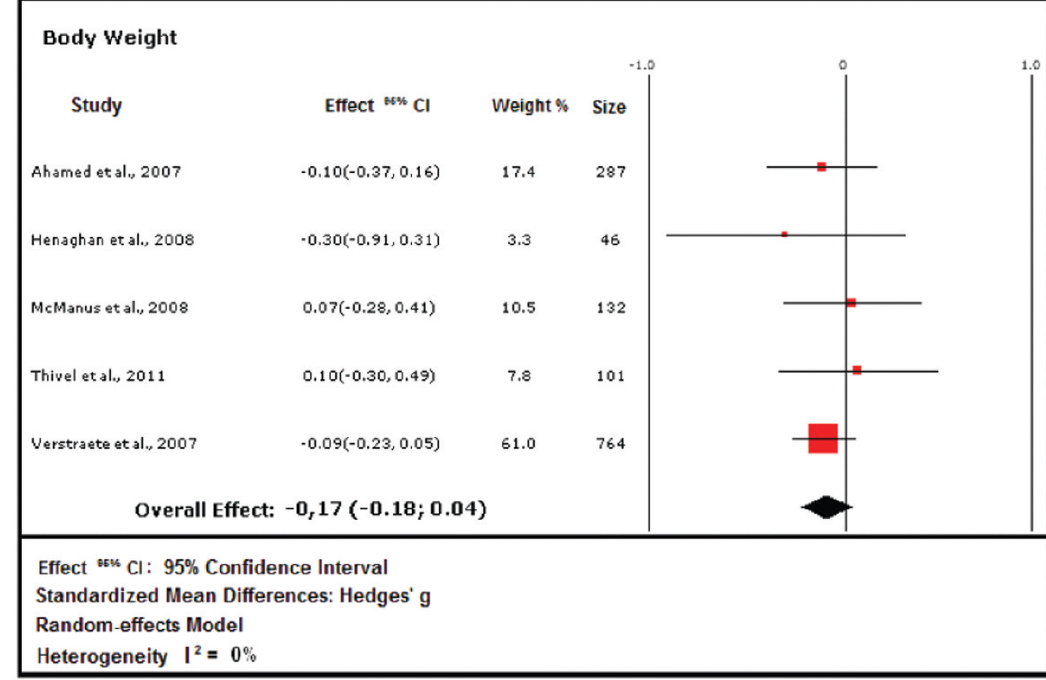
Figure 4 - Comparison of the effects of school-based interventions on changes in body weight compared with controls.